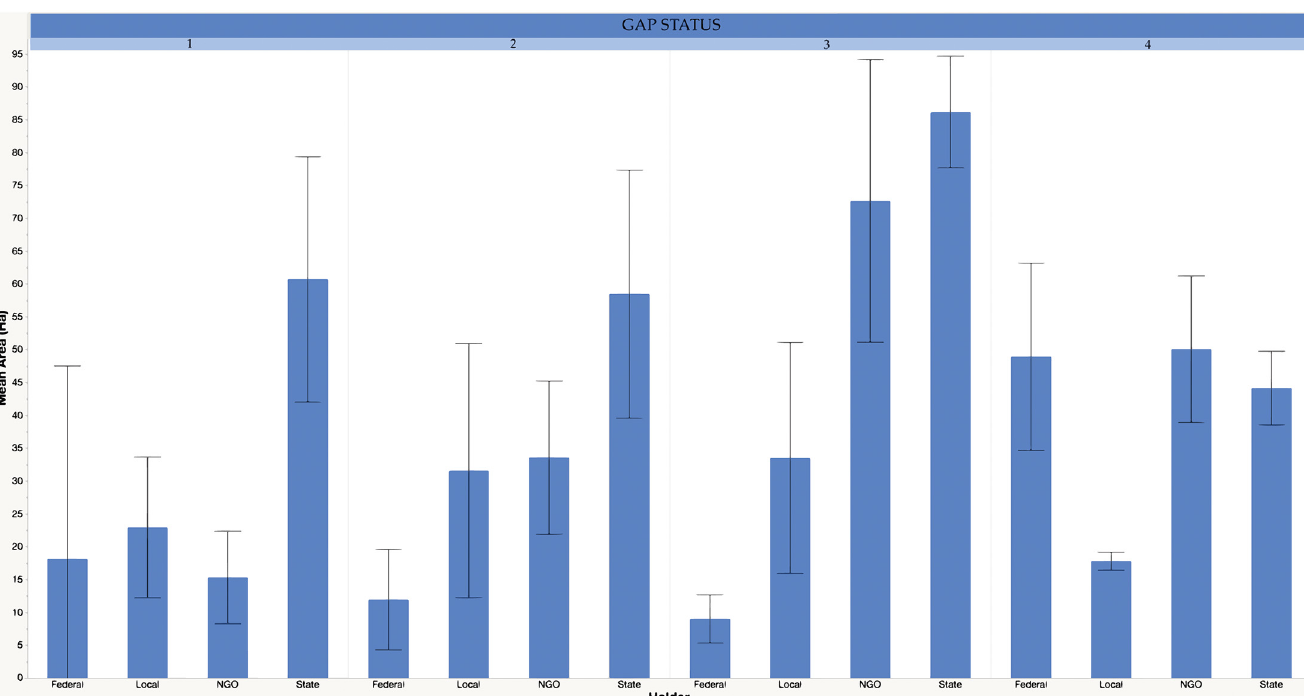
Fig 2. Mean area (ha) and numbers (N) of conservation easements by easement holder in each GAP level (1 – 4) within the Appalachian LCC. There are 363,000 ha of easements in the region; 87% of the easements are in the multiple-use GAP categories 3 – 4. The relatively high mean area of Federally- held easements in GAP 4 is due to the existence of a few, large